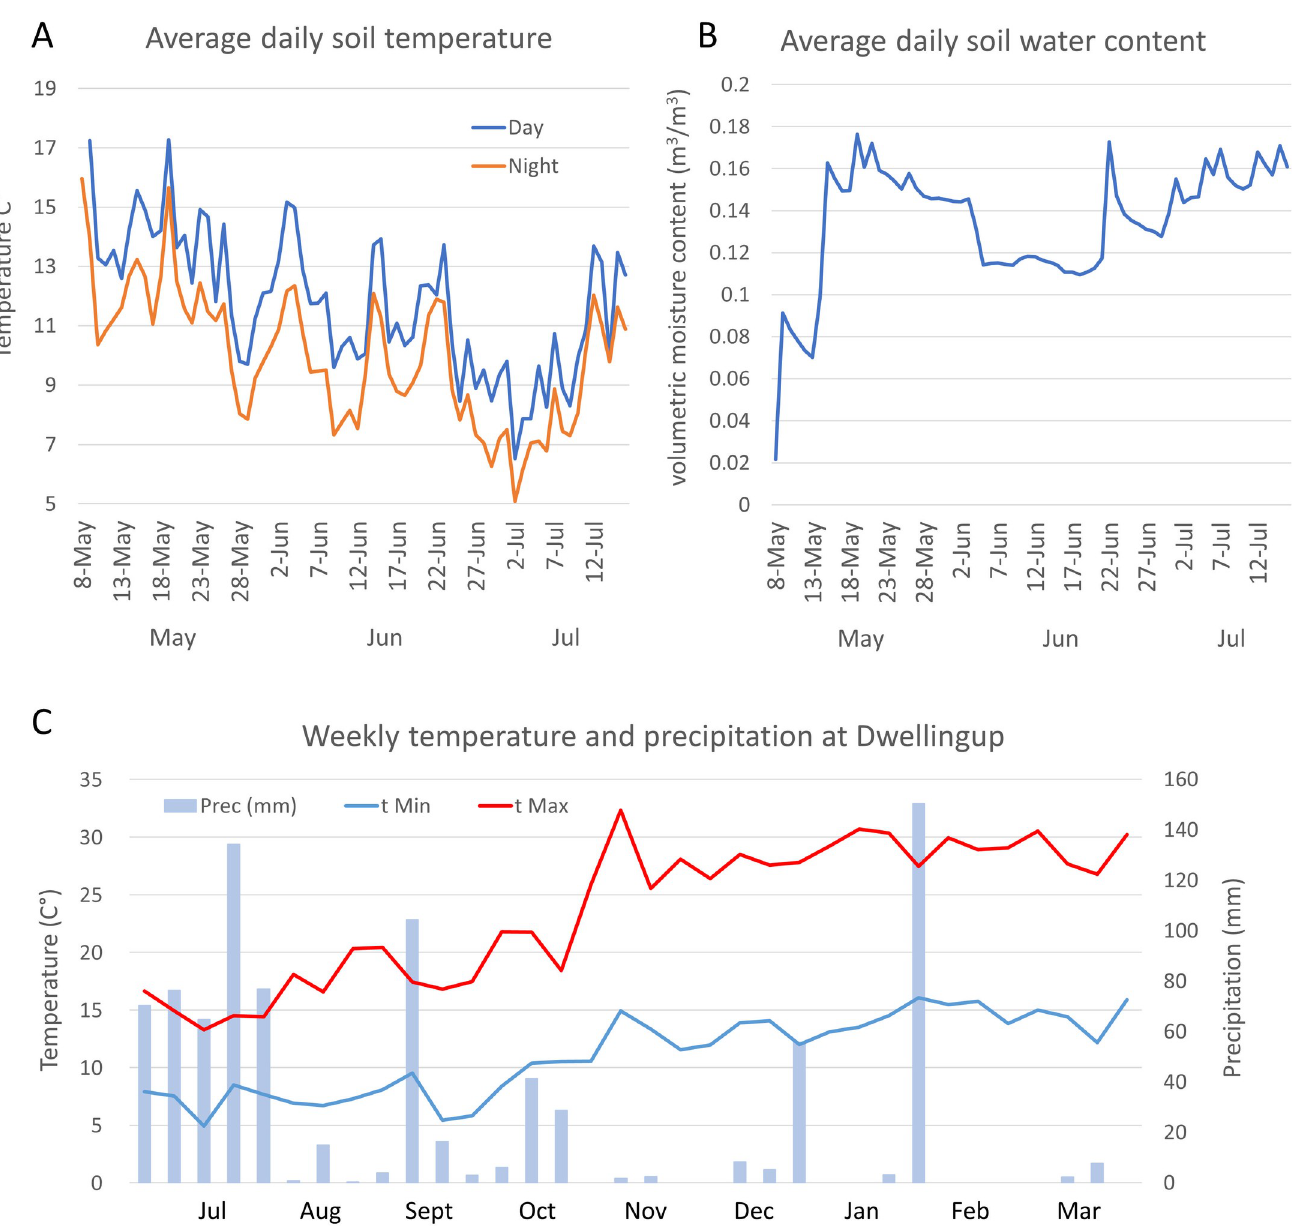
Fig 2. Climate condition at the field site. (A) the daily average for day (orange) and night (blue) temperature (B) volumetric water content in the soil at 1 cm depth for the first 10 weeks of the experiment, when germination and emergence were recorded. (C) Weekly maximum (tMax) and minimum (tMin) temperature, and total precipitation (Prec (mm)) for the period between the end of the emergence experiment and the recording of plant survival (July 2017–March 2018) at a nearby meteorological station.